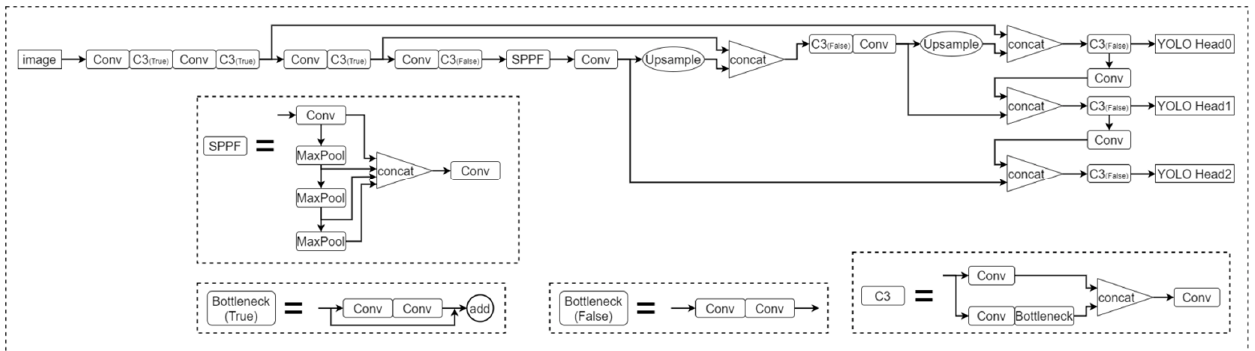
Figure 2. Partial GPR Dataset Diagram.